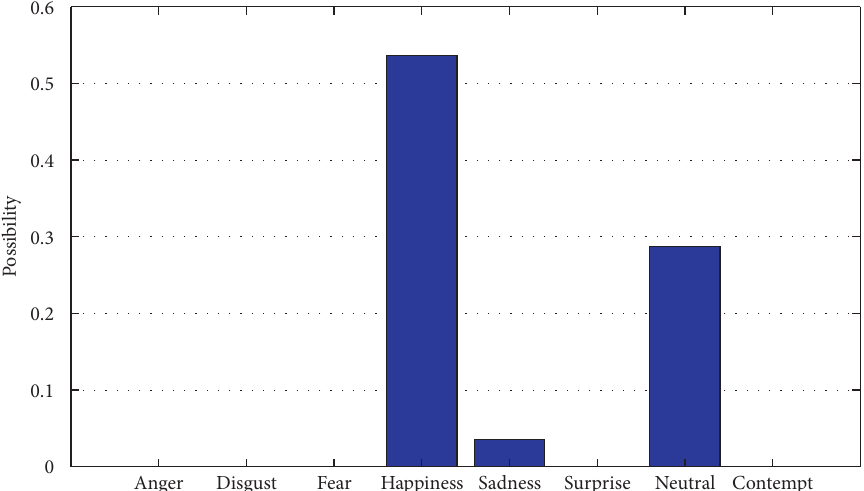
Figure 7: The probability distribution of